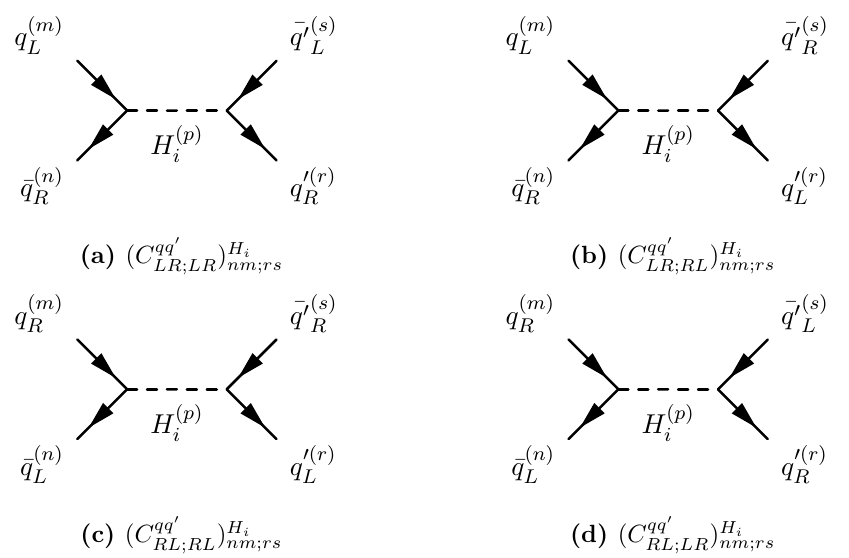
Figure 4. The Feynman diagrams that give rise to the e(cid:11)ective 4-fermion interactions discussed in eq. (6.20). Here, H ( p ) i substitution H ( p )